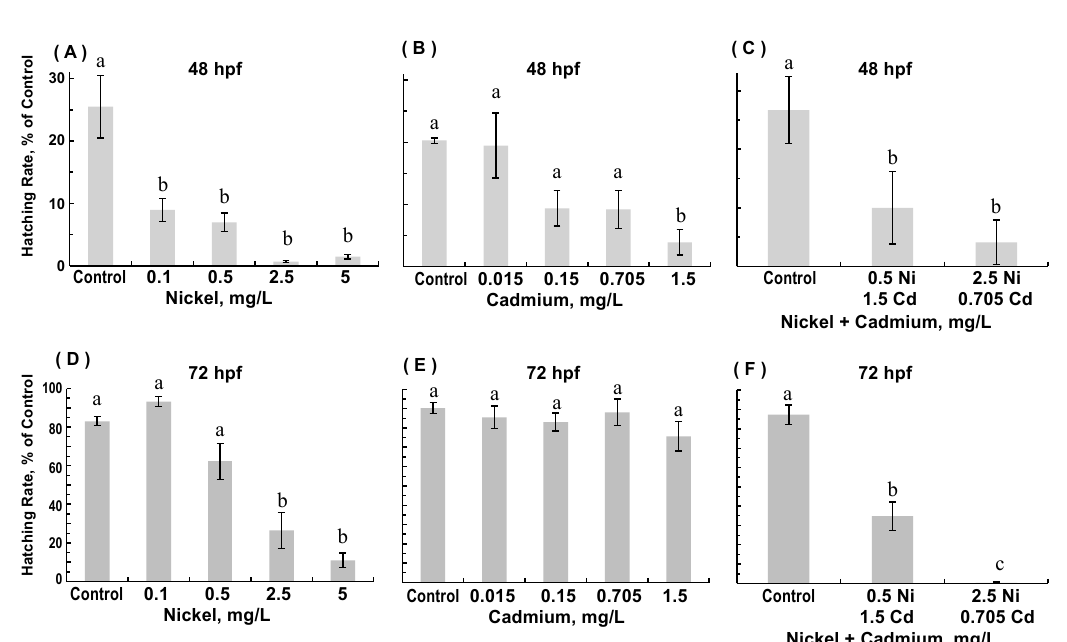
Figure 1. Hatching rate at 48 hpf ( A – C ) and 72 hpf ( D – F ) zebrafish embryos (survivors) reared in medium containing 0.1–5 mg / L nickel (Ni), 0.15–1.5 mg / L cadmium (Cd), and combinations of 0.5 mg / L Ni + 0.15 Cd or 2.5 mg / L Ni + 0.705 mg / L Cd. Note: In all figures, within a given panel, statistical similarity is denoted with the same letter ( p < 0.05). (Data are means ± SEM for N = 50–80).